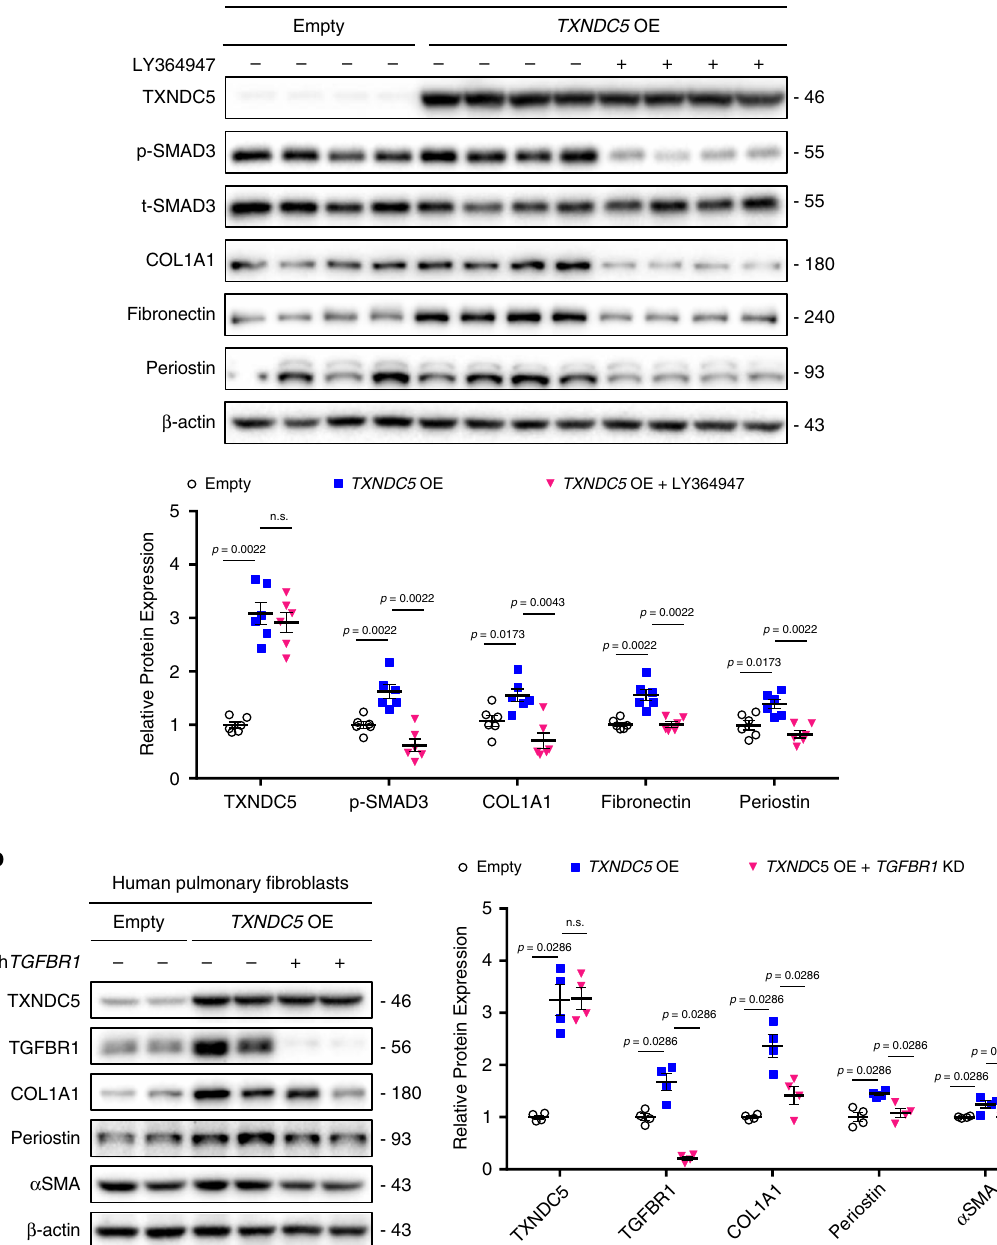
Fig. 7 TXNDC5-induced pulmonary fi broblast activation and ECM production requires TGFBR1. a Forced expression of TXNDC5 in HPF led to increased SMAD3 phosphorylation, fi broblast activation (as evidenced by increased periostin levels) and ECM (COL1A1 and fi bronectin) production, all of which were abolished completely by the treatment of LY364947 (10 μ M for 48 h), a TGFBR1 kinase inhibitor (n = 6 biologically independent samples per group). b Knockdown of TGFBR1 reversed TXNDC5 overexpression-induced COL1A1, periostin, and α SMA expression ( n = 4 biologically independent samples per group) (Data are presented as mean ± SEM, P value determined using two-tailed Mann – Whitney U test. Source data are provided as a Source Data fi le. n.s. non-signi fi cant, KD knockdown, OE overexpress, shTGFBR1 TGFBR1 knockdown with